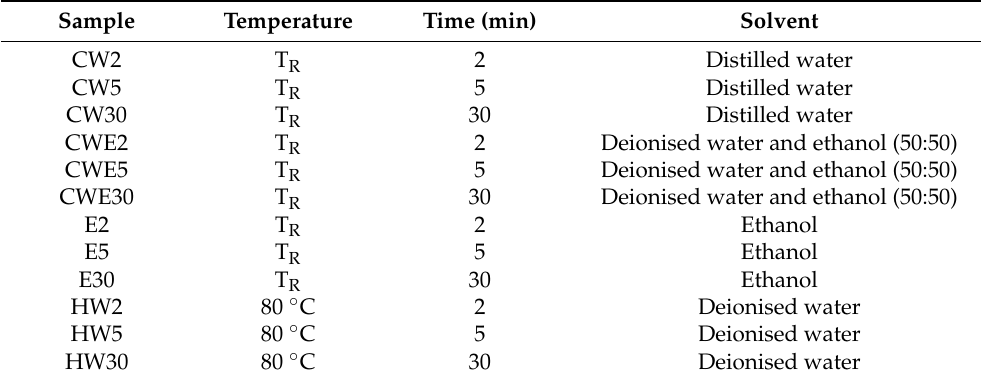
Table 7. Conditions for the extraction of polyphenolic compounds from bark with cold water (CW), ethanol (E), and hot water (HW) at different extraction